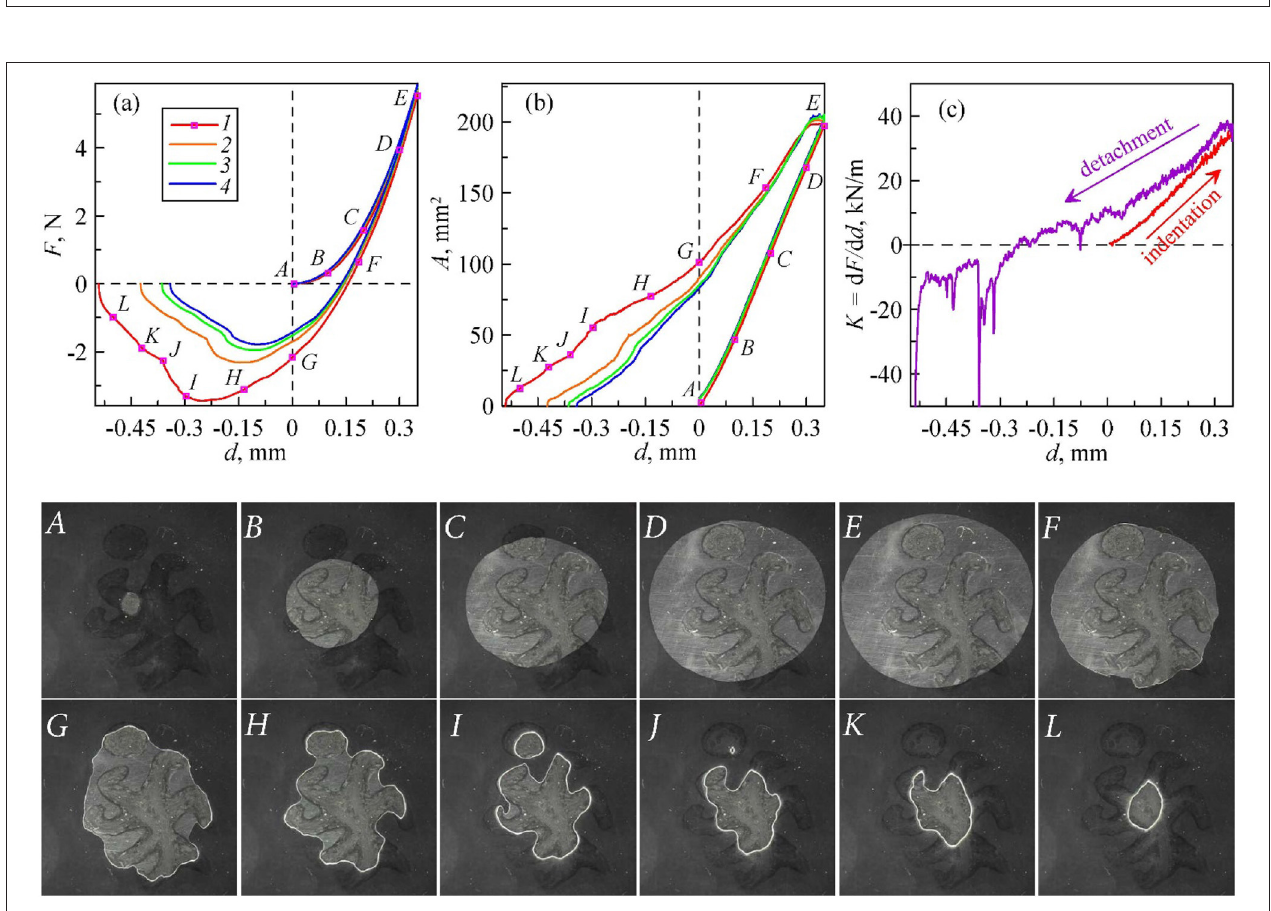
FIGURE 4 | Dependences of (a) the normal force, (b) contact area, and (c) contact stiffness on indentation depth in indentation test of a steel ball with chemically heterogeneous surface into a rubber sheet. Solid lines with different colors show the results of four cycles in a series. Contact stiffness is shown only for the first indentation cycle. The lower part of the figure shows snapshots of contact area with size 17mm × 17mm for the first indentation cycle. These images correspond to the points marked with the same letters in subplots (a) and (b) .